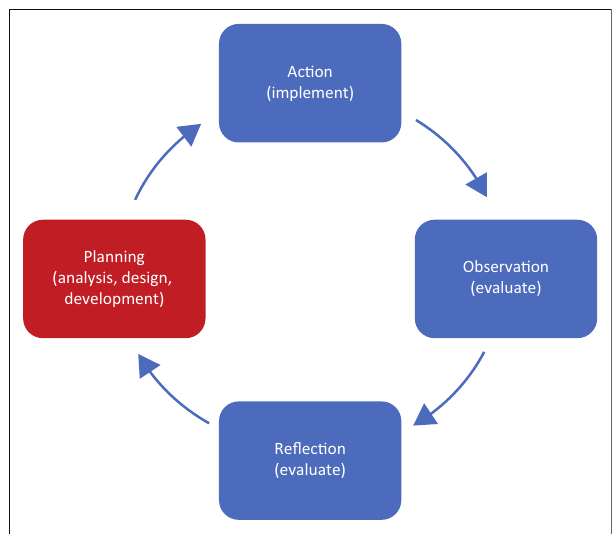
FIGURE 2: Diagrammatic representation of the methods. The cycle illustrates the 4 steps of the cooperative inquiry (planning, action, observation and reflection) with the relevant steps of the analyse, design, develop, implement, evaluate model in brackets. This article focuses on the planning step of the cooperative